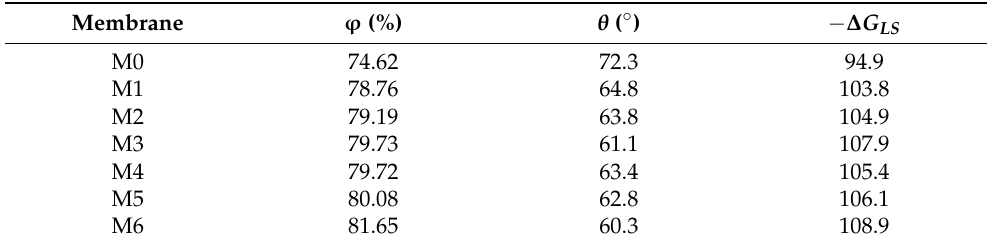
Table 2. Physicochemical properties for the hybrid ultrafiltration membranes: water uptake; φ , con- tact angles; θ and free surface energy; −∆𝐺 (cid:3013)(cid:3020) .